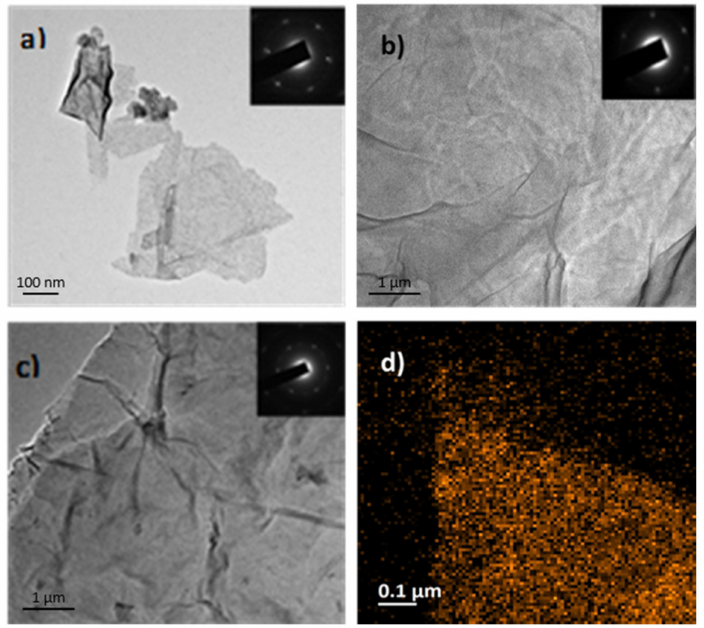
Figure 4. Mapping TEM image analysis of ( a ) GO, ( b ) GO-PDDA, ( c ) AMG, and ( d ) nitrogen- mapped AMG.